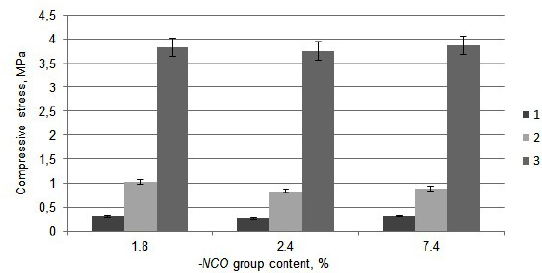
Figure 3. Variation in compressive stress with polymer binder’s re- activity at different deformation levels (1 - 30%; 2 - 50%; 3 - 67 (Max) %) of composite material (formation condi- tions: T a = 17 - 20 ◦ C; P = 0.004 MPa, binders content - 18 wt.%).